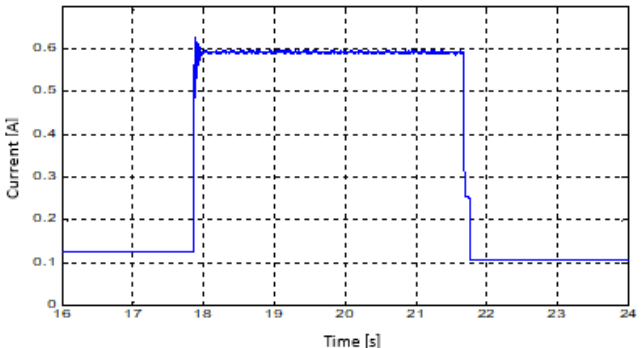
Figure 21. Current course measurement. Table 3. Outputs from the measurement of the individual cutting disc drive system.